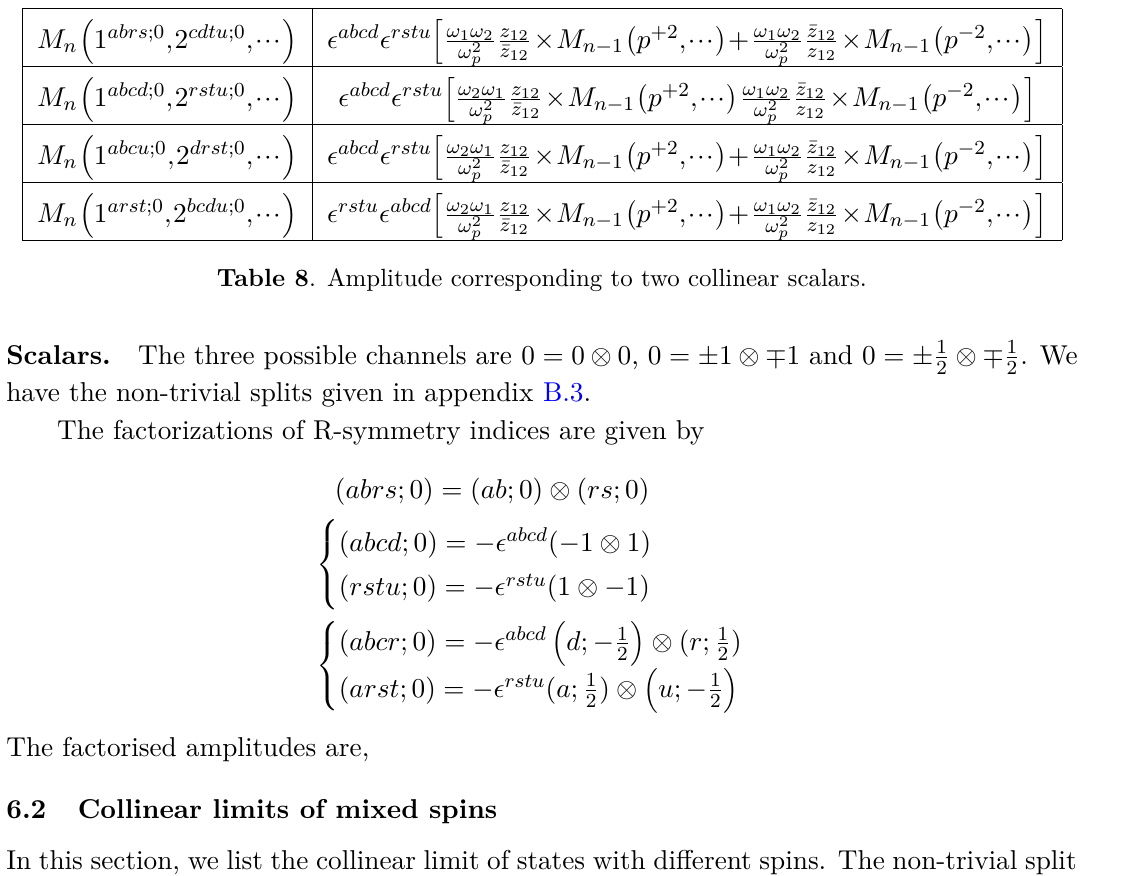
Table 7 . Amplitude corresponding to two collinear graviphotinos.